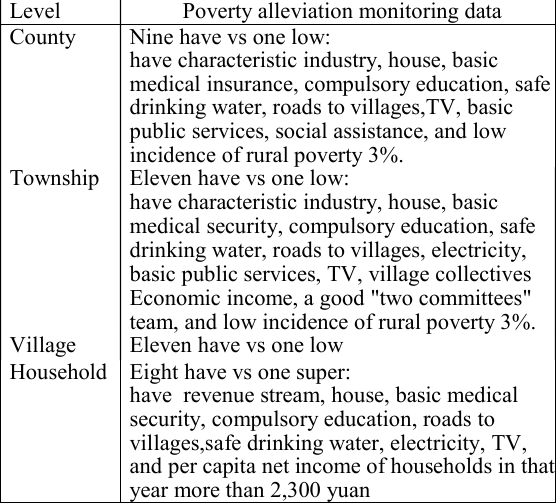
Table 1. Poverty alleviation monitoring